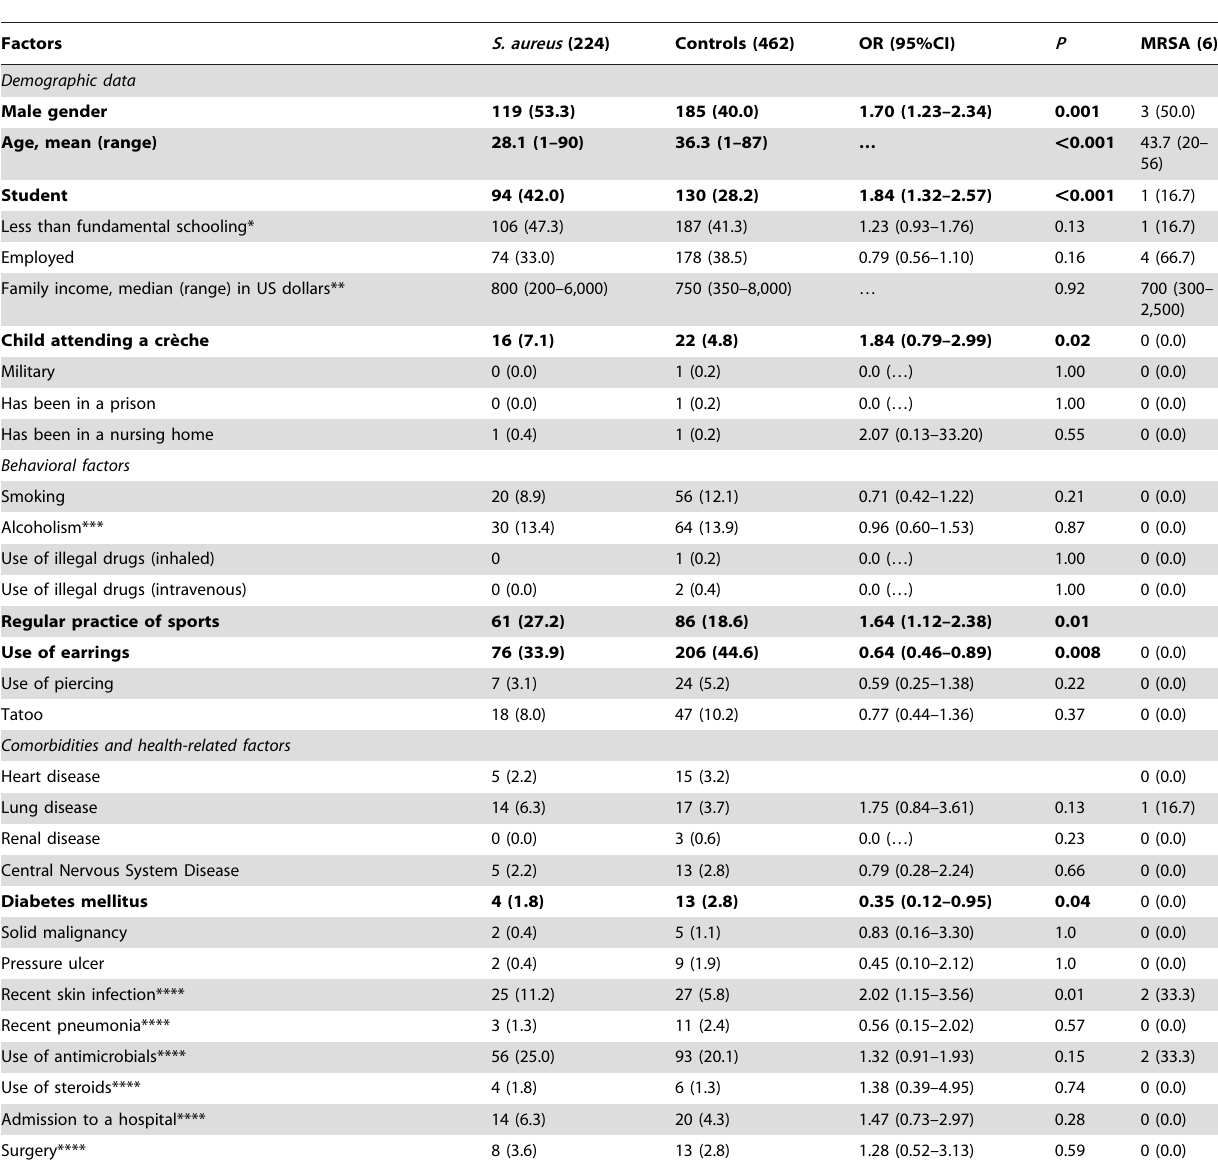
Table 1. Bivariate analysis of factors associated with nasal carriage of Staphylococcus aureus among persons living in the city of Botucatu, Brazil, alongside with data from six MRSA carriers in that